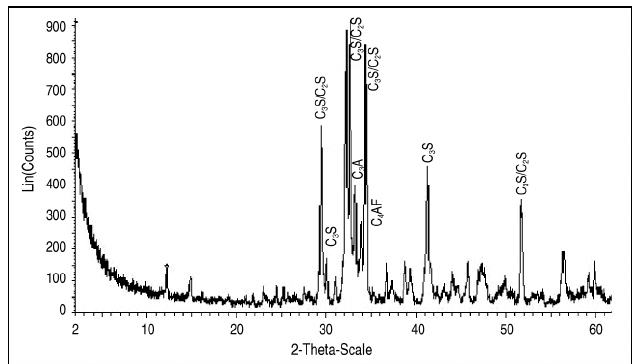
Fig. 1. X-rays diffractogram of anhydrous cement CEM